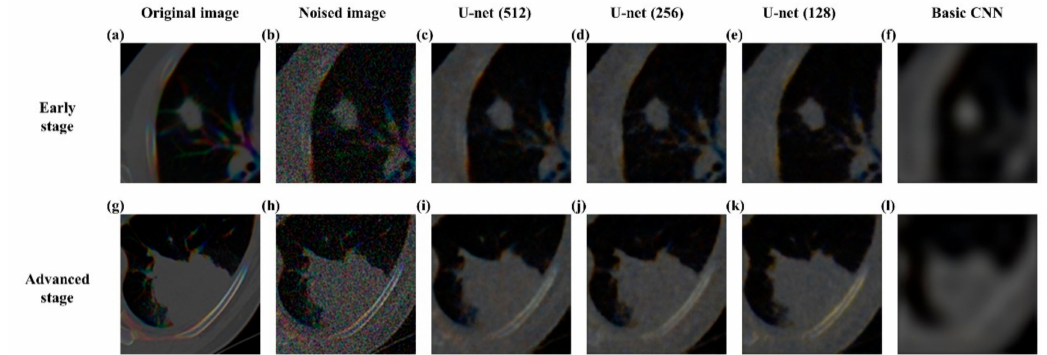
Figure 3. Representative reconstruction results of our U-net autoencoder, U-net (256), U-net (128), and basic CNN reconstruc- tion model. ( a ) Original image of NSCLC patients in early-stage ( b ) noise added images of NSCLC patients in early-stage ( c ) reconstructed images of the proposed U-net (512) autoencoder in early-stage ( d ) reconstructed images of U-net autoencoder using latent variables with 256 channels in early-stage ( e ) reconstructed images of U-net autoencoder using latent variables with 128 channels in early-stage ( f ) reconstructed images of the basic CNN reconstruction in early-stage ( g ) original image of NSCLC patients in advanced-stage ( h ) noise added images of NSCLC patients in advanced-stage ( i ) reconstructed images of the proposed U-net autoencoder (512) in advanced-stage ( j ) reconstructed images of U-net autoencoder using latent variables with 256 channels in advanced-stage ( k ) reconstructed images of U-net autoencoder using latent variables with 128 channels in advanced-stage ( l ) reconstructed images of the basic CNN reconstruction in